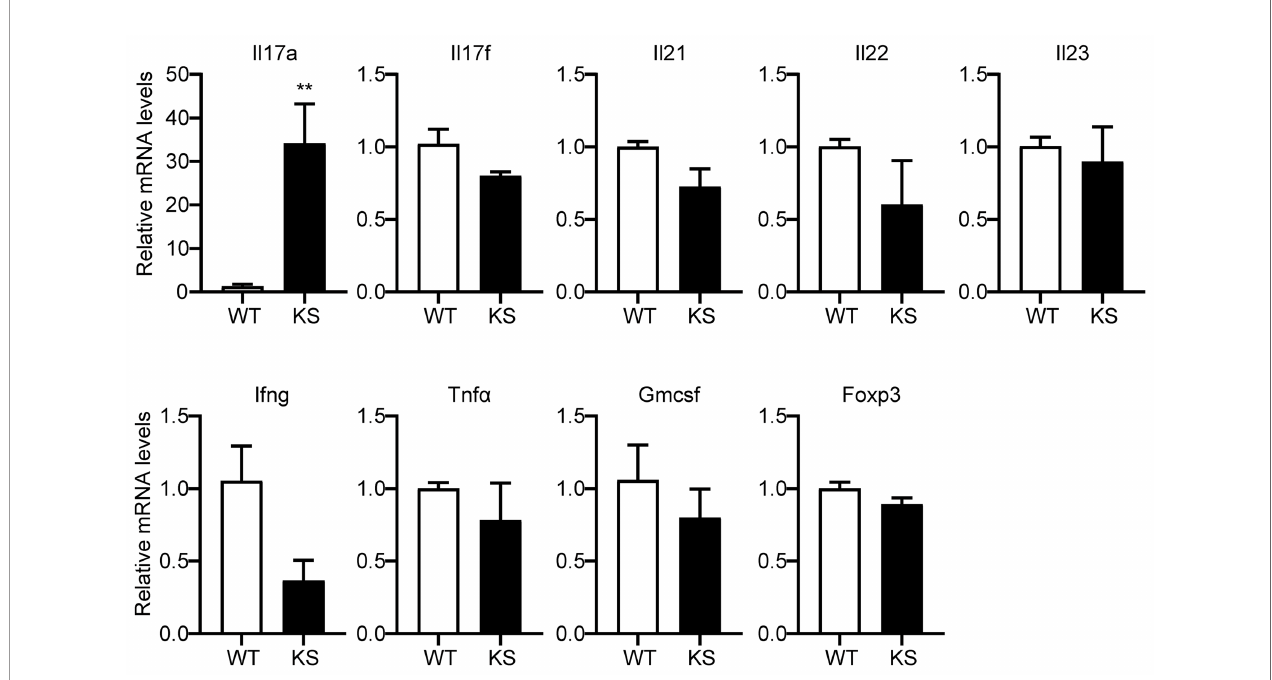
FIGURE 6 | Kallistatin overexpression favors mRNA expression of Il17a in CD4 + T cells. The total CD4 + T cells were sorted from spleens of unimmunized (naïve) WT or KS mice using a mouse CD4 + T cell enrichment kit. Quantitative real-time PCR analysis was performed to determine the relative mRNA expression levels of Il17a, Il17f, Il21, Il22, Il23, Ifng, Tnf a , Gmcsf and Foxp3 . The gene levels were normalized using Gapdh , and the level of each gene was expressed as a ratio of WT group. Data are mean ± SEM (n = 3-5 mice). **p < 0.01. (Unpaired Student ’ s t